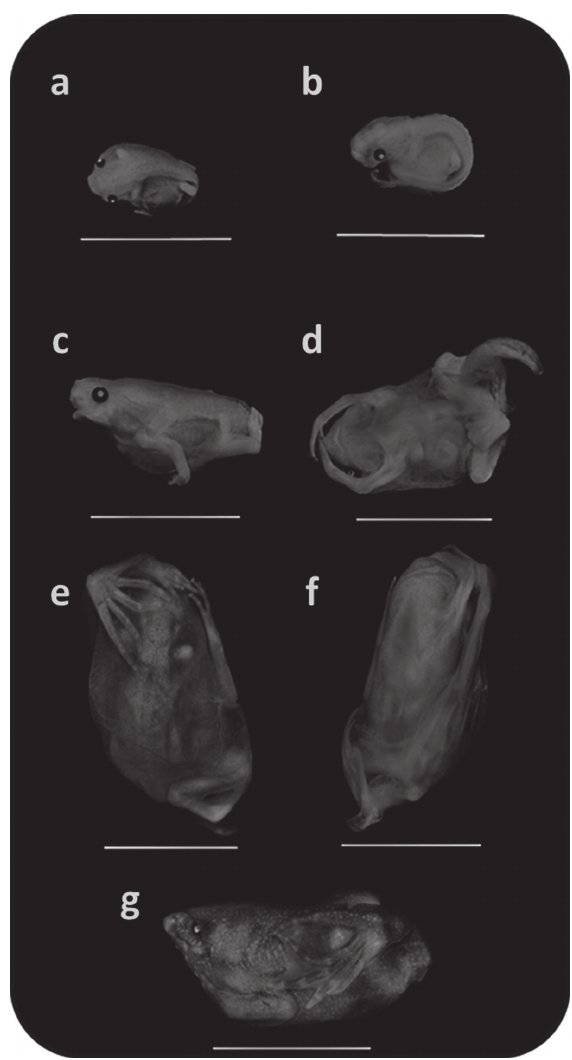
Figure 1 - Pipa arrabali embryos. a : Dorsal view of Stage II-2 (CHUnB 35027-D); b : Left lateral view of Stage II-3 (CHUnB 35055-D); c : Left lateral view of Stage II-5 (CHUnB 35045- D); d : ventral view of Stage II-6 (CHUnB 35019-D); e : Dorsal view of Stage II-10; f : ventral view of Stage II-10 (CHUnB 35013-D); g : Left lateral view of Stage II-11(CHUnB 35053- D). Scale bars = 5